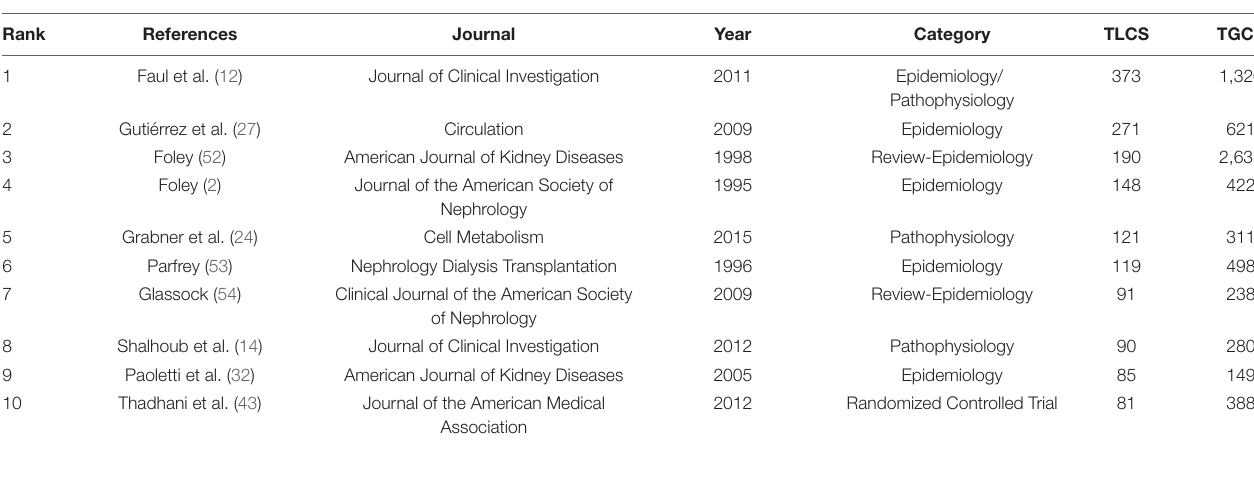
TABLE 5 | The top 10 publications with the highest total local citation score